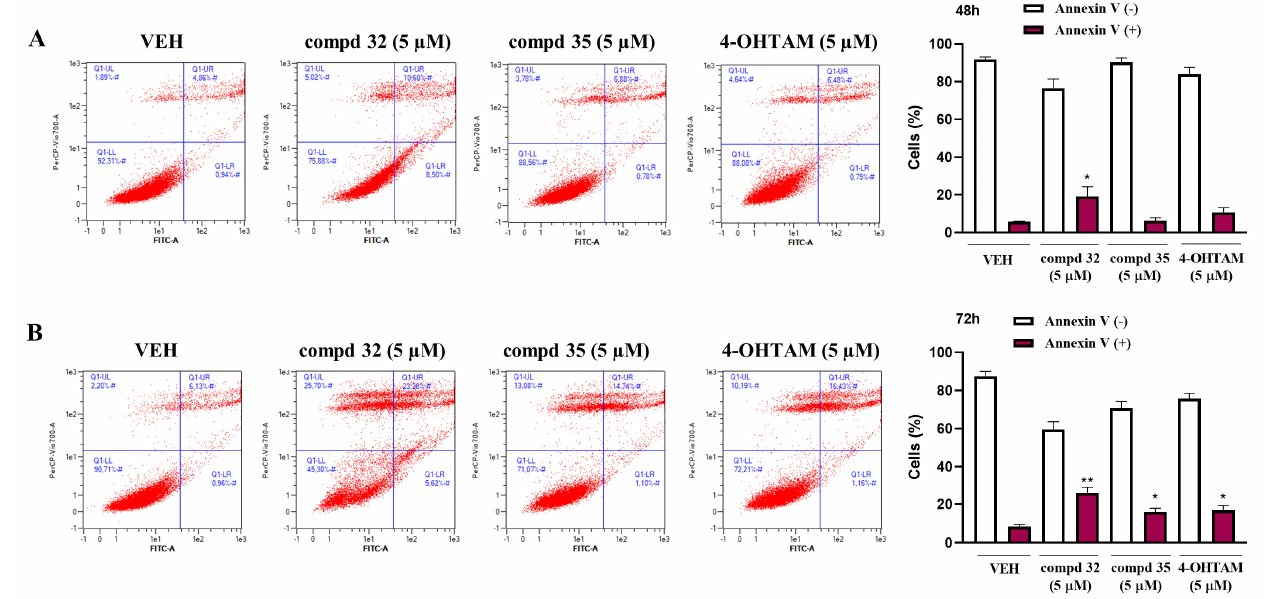
Figure 13. 5-Hydroxy-2 H -pyrrol-2-ones 32 and 35 induce apoptosis in human ER+ breast cancer cells in a time dependent-manner. Apoptosis was measured in T47D cells treated with vehicle (VEH, 0.05% DMSO), 4-OHT (5 µ M), compounds 32 or 35 (both, 5 µ M) for 48 h ( A ) or 72 h ( B ) using the Annexin V-FITC/Propidium Iodide (PI) apoptosis detection kit. ( A, B, Left panel ) Representative FACS images of phosphatidylserine translocation to the cell surface measurements, distinguishing viable cells (lower left quadrant, Q1-LL), cells in early apoptosis (lower right quadrant, Q2-LR) and cells in an advanced death phase (upper right quadrant, Q3-UR). ( A , B, Right panel ) Quantification of the percentages of viable Annexin V (–) (white bars) versus apoptotic Annexin V (+) (purple bars) cells for each treatment and time-point shown in left panel. Graphs are representative of at least three independent experiments, each performed in triplicate. Statistical significance was assessed by mean comparisons of each treatment condition using a two-tailed T-Student. * p < 0.05; ** p < 0.01 versus VEH-treated cells in each Annexin V group at each time-point.